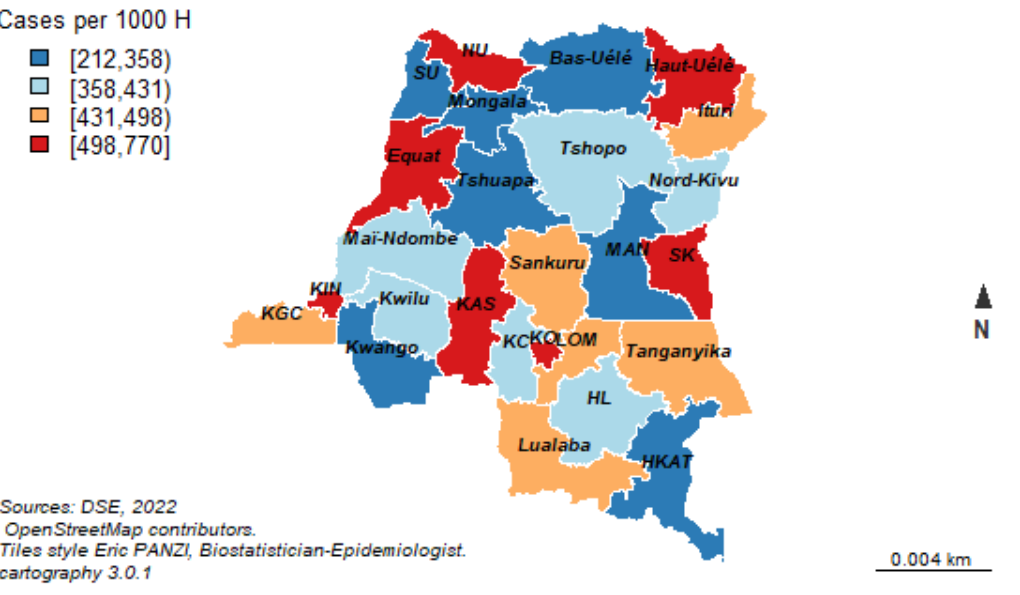
Figure 5. Spatial distribution of malaria morbidity and mortality from 2001 to 2019. Note: The legend of the provinces, see the Appendices A and B.